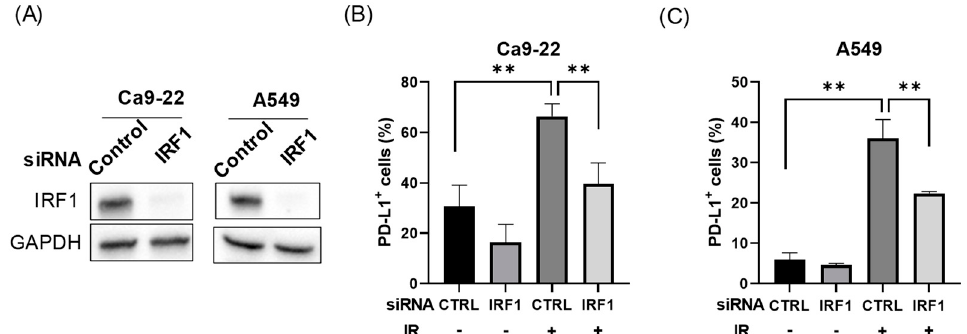
Figure 2. Involvement of IRF1 in radiation-increased PD-L1 expression in Ca9-22 and A549 cells. ( A ) Ca9-22 and A549 cells transfected with control or IRF1 siRNA were harvested for western blot analysis. An image of a representative im- munoblot is shown. GAPDH was used as a loading control. ( B , C ) IRF1-knockdown Ca9-22 ( B ) and A549 cells ( C ) were irradiated with 6 Gy and cultured for 4 days. After culturing, the cells were harvested for analysis of cell surface PD-L1 expression. ** p < 0.01.